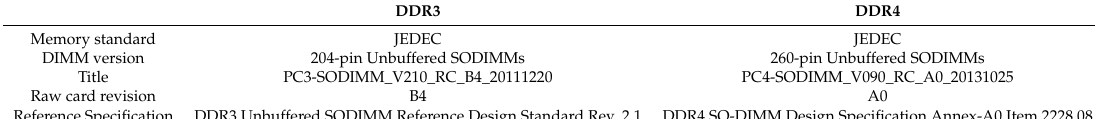
Table 1. Design file (DIMM) information of analyzed memory modules.